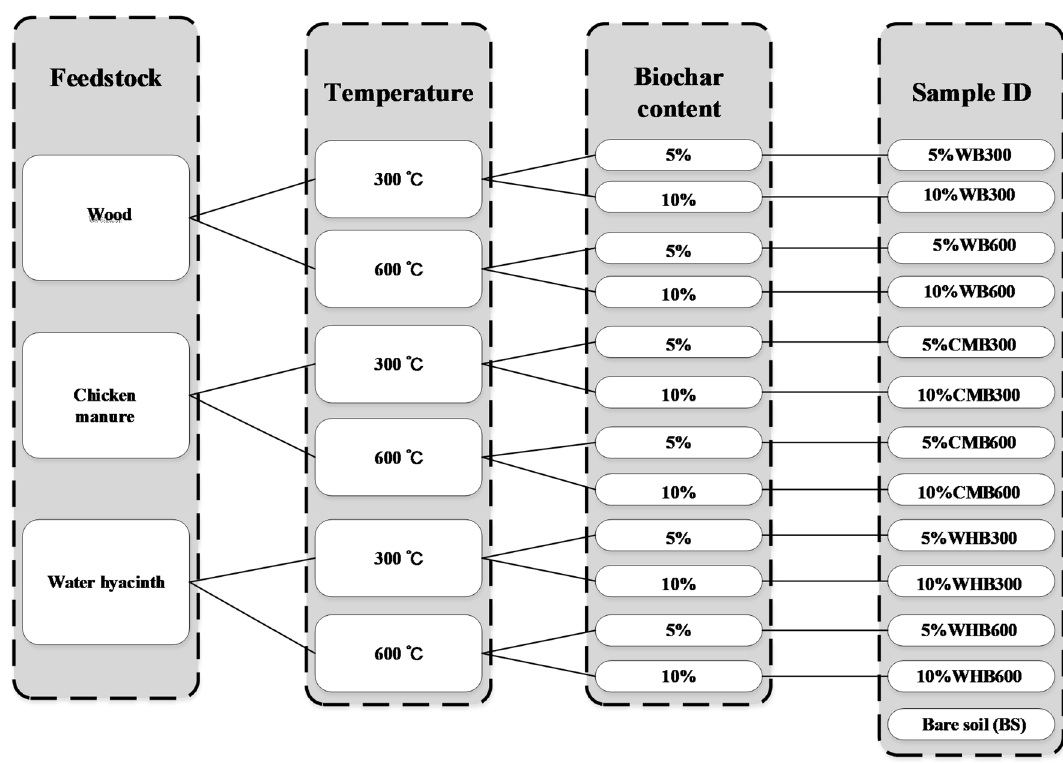
Figure 5. Biochar production conditions and sample